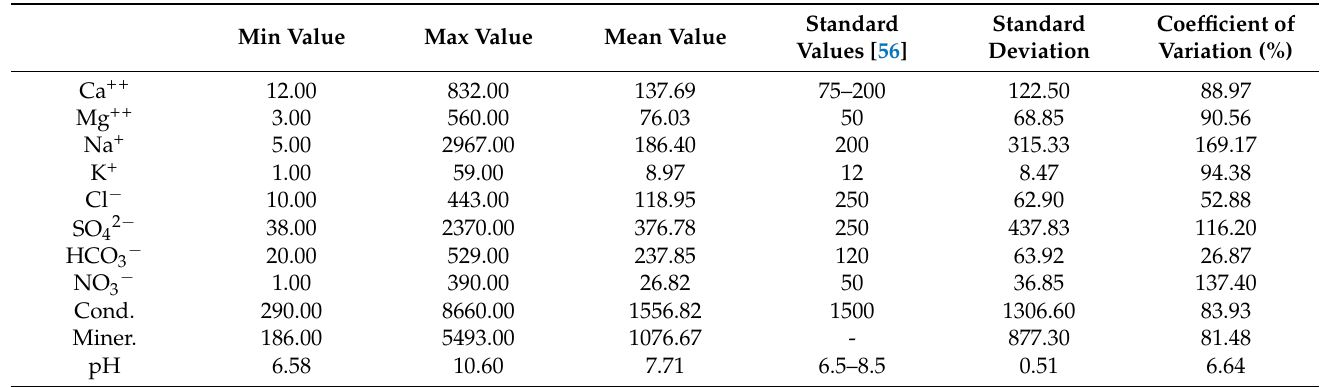
Table 3. Descriptive statistics of groundwater parameters of the Wilaya of Na â ma.